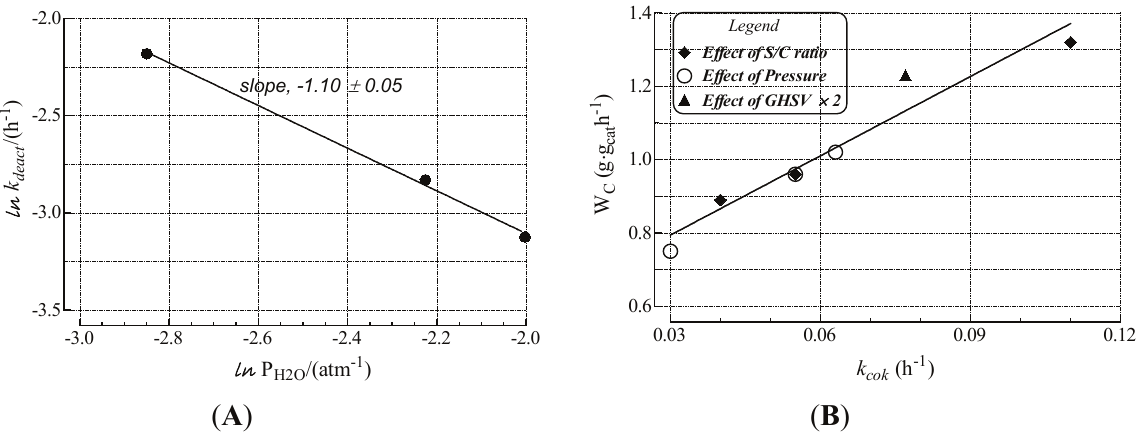
Figure 6. Log-plot of the kinetic constant of coking vs. water partial pressure ( A ); and Relationship between the weight gain of the used samples (Table 1) and the kinetic constant of coking (Table 2) at different reaction conditions ( B